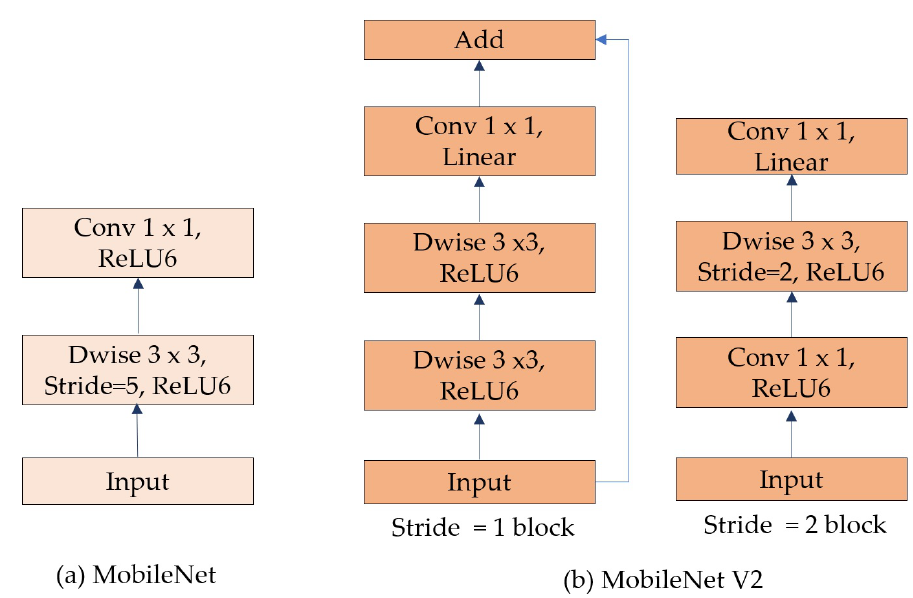
Figure 6. ( a ) MobileNet model architecture and ( b ) MobileNetV2 model architecture.